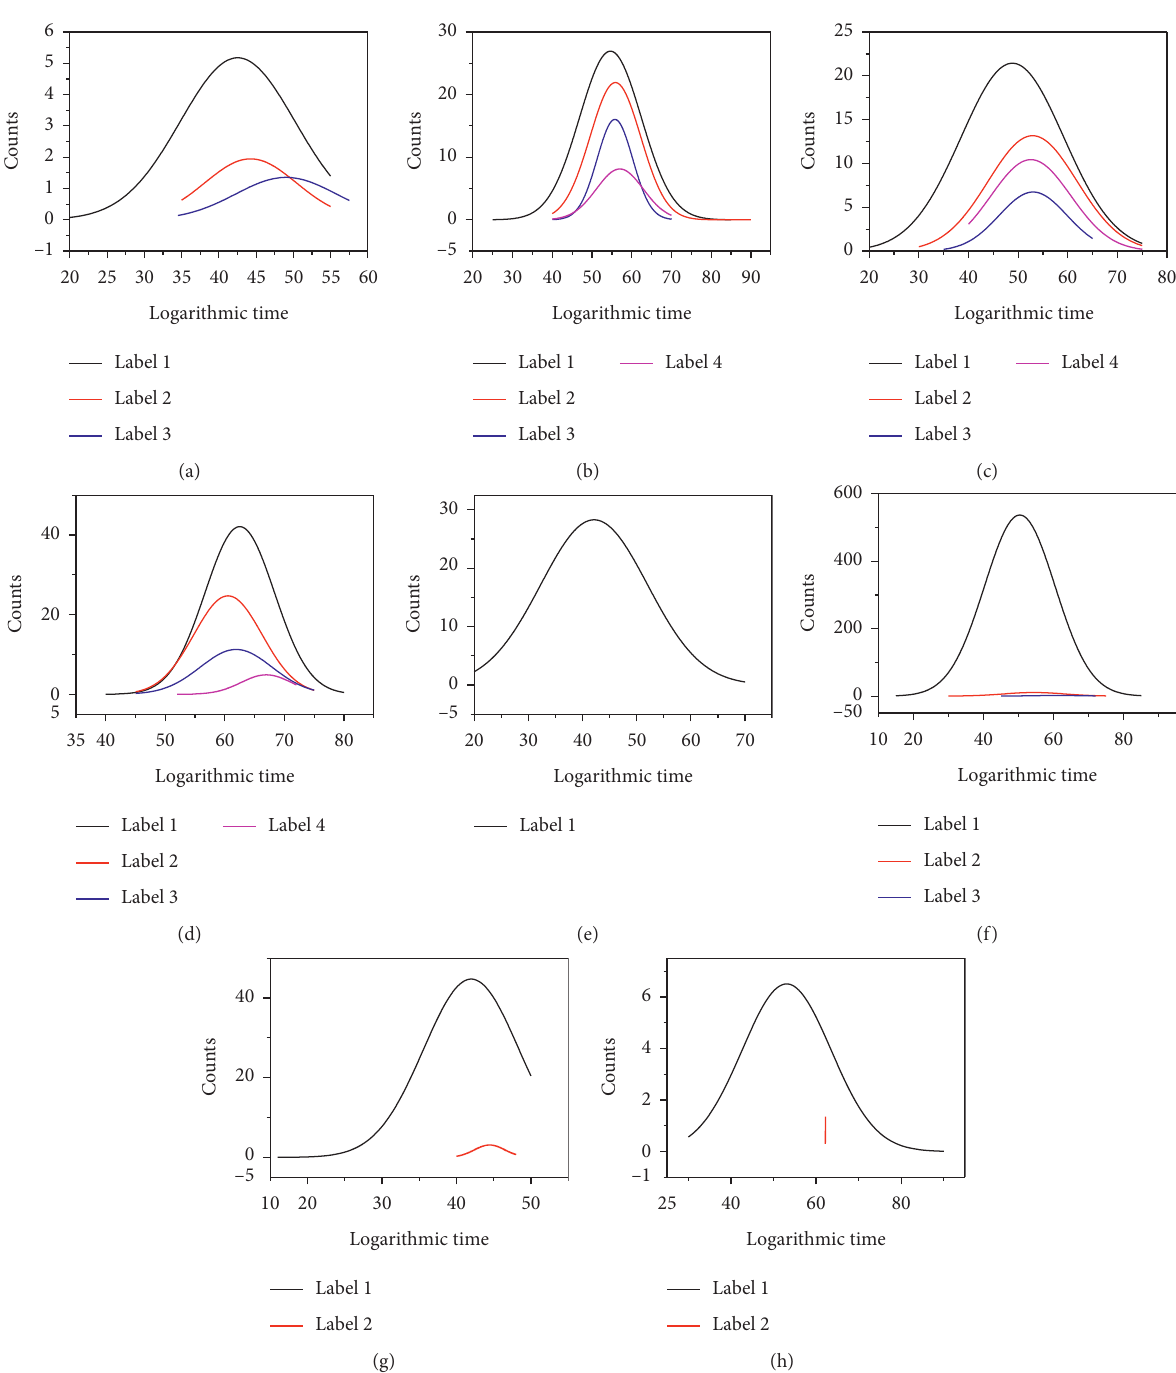
Figure 2: Logarithmic time distribution curve of network